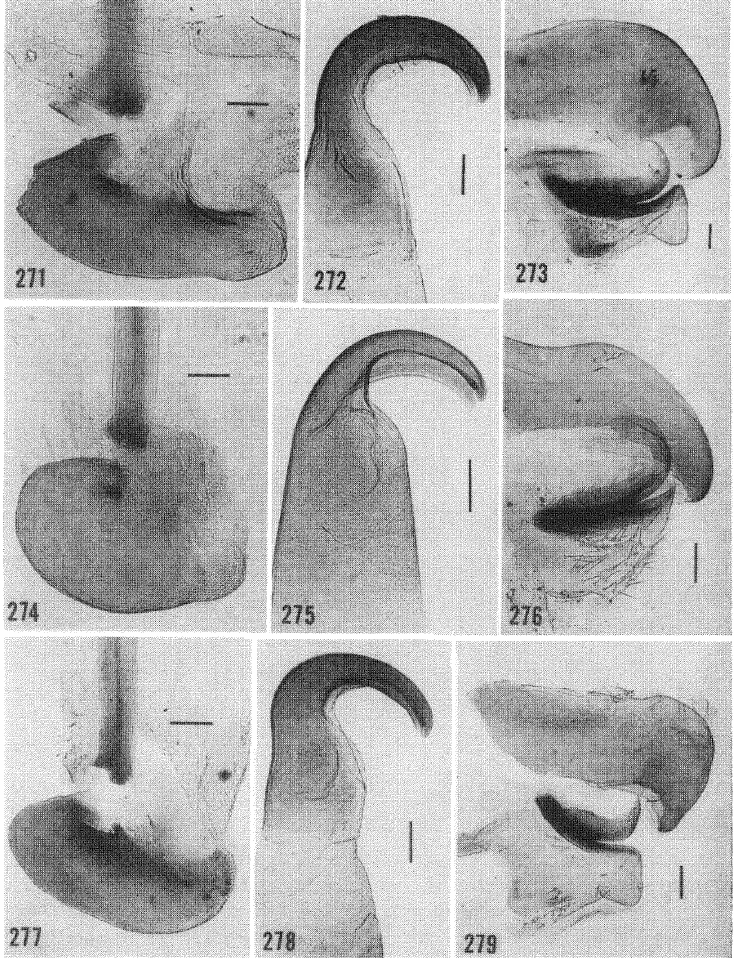
Figues 271-279. Male genlital phallomeres of Trichoblatta spp. 271-273. (986 L). T. magnifica (from 6 shown in Fig. 268). 274-276. (988 L). T. oniscina (from 6 shown in Fig. 267). 277-279. (985 L). T. tarsaIis (from shown in Fig. 264). (scale 0.1